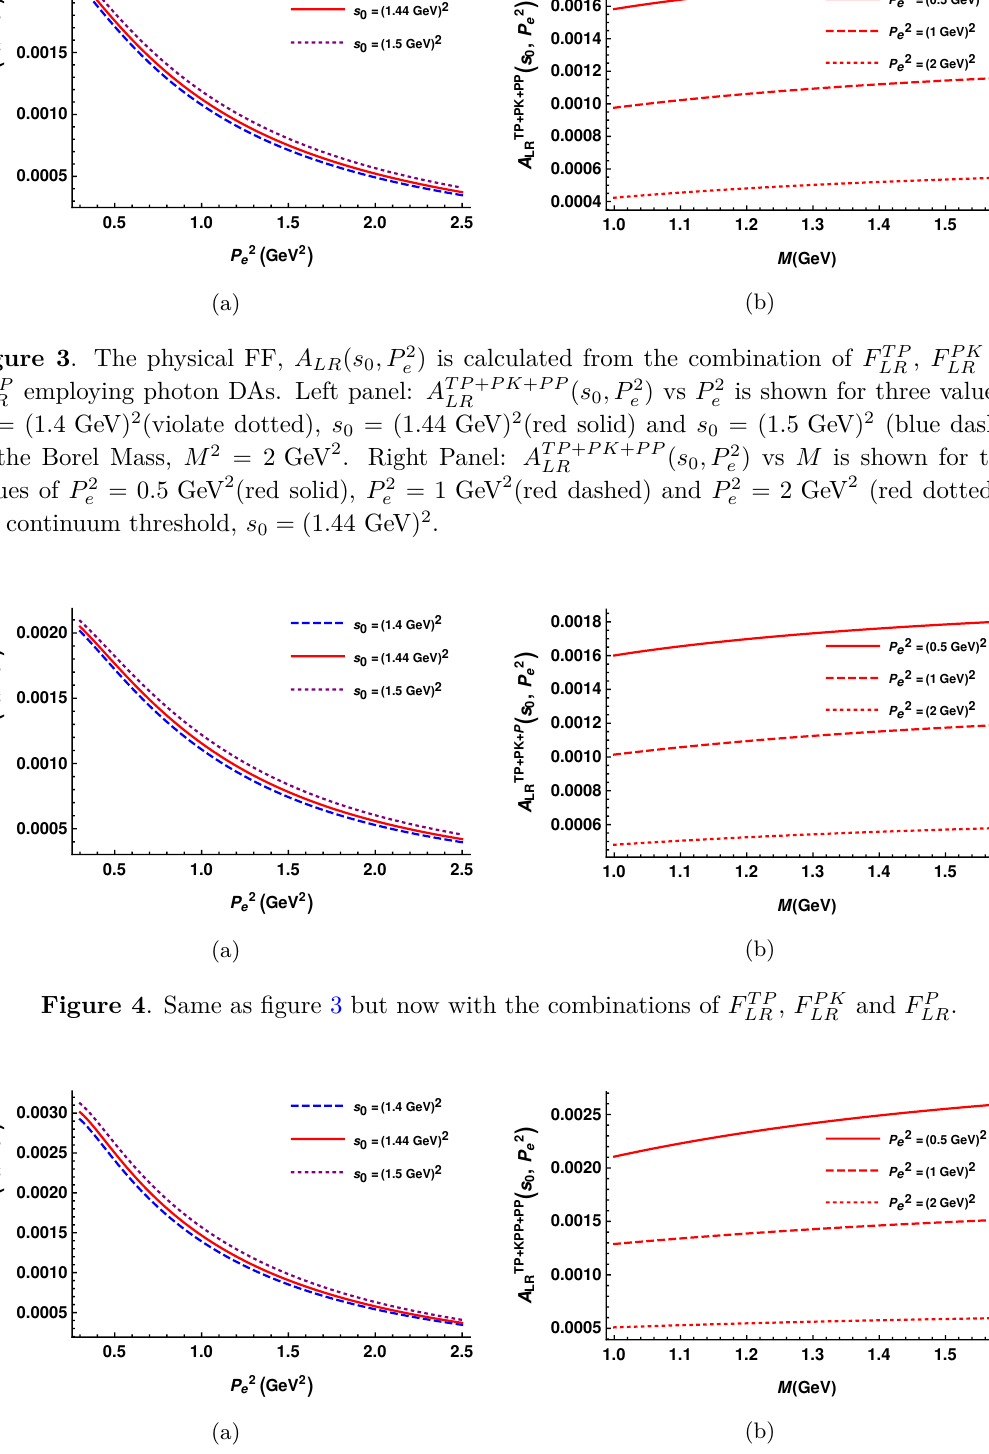
Figure 5 . Same as figure 3 but now with the combinations of F TP